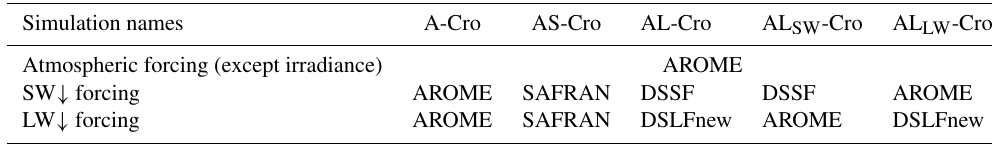
Table 2. Characteristics of the snowpack simulations.